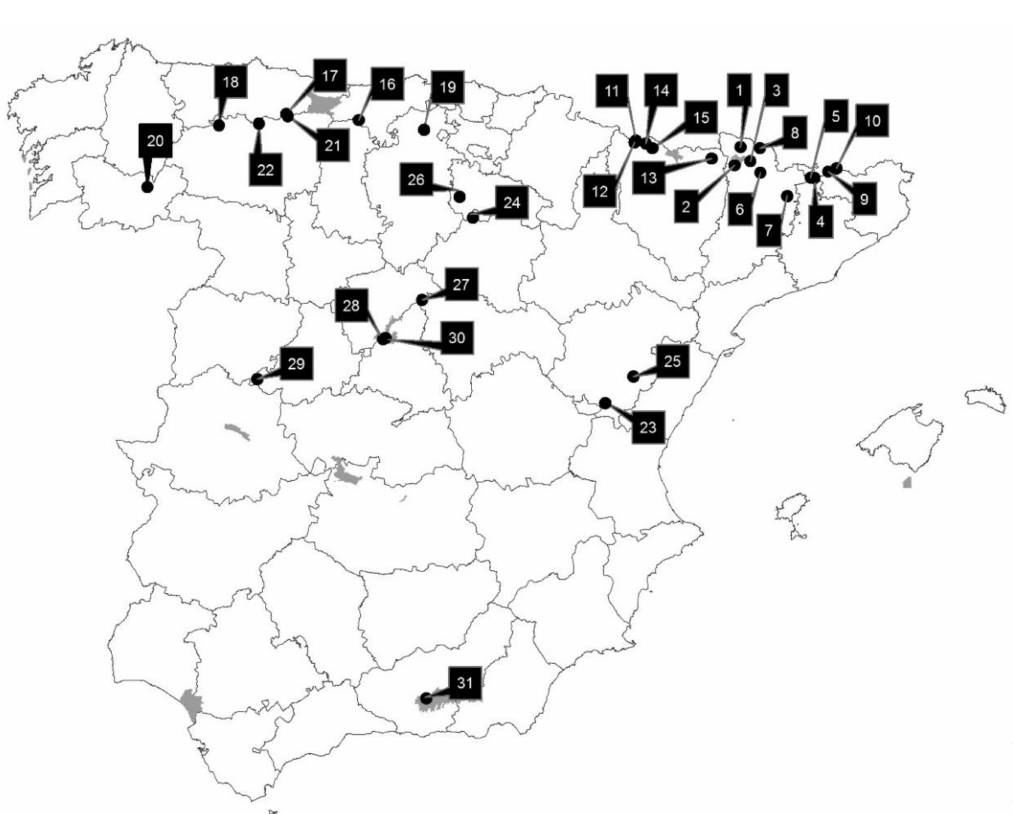
Figure A1. Map of alpine ski resorts and Natural Parks in Spain. Source: Based on http://www. redeuroparc.org/descargasmapas.jsp (accessed in December 2015). Legend: Same information as Figure